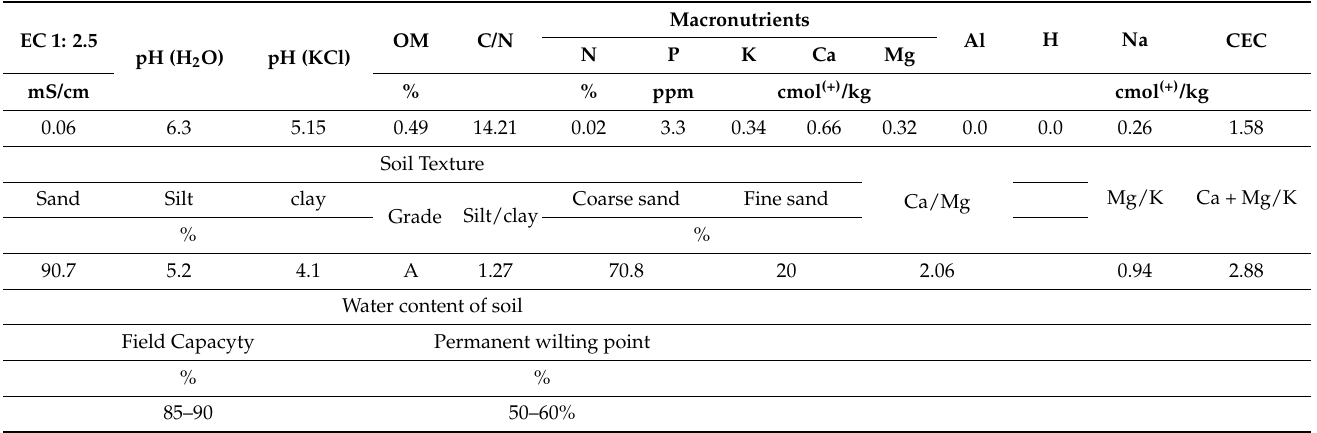
Table 1. Chemical analysis of the soil used in pot